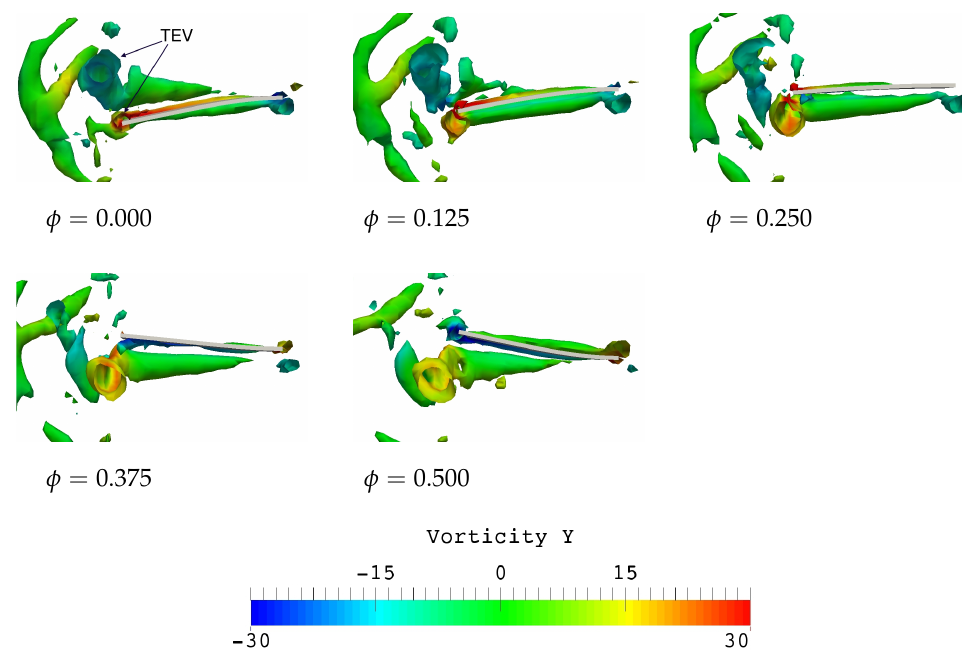
Figure 10. Three-dimensional vortex structures around the plate during a half-flapping cycle for the case of f ∗ = 0.93 (case